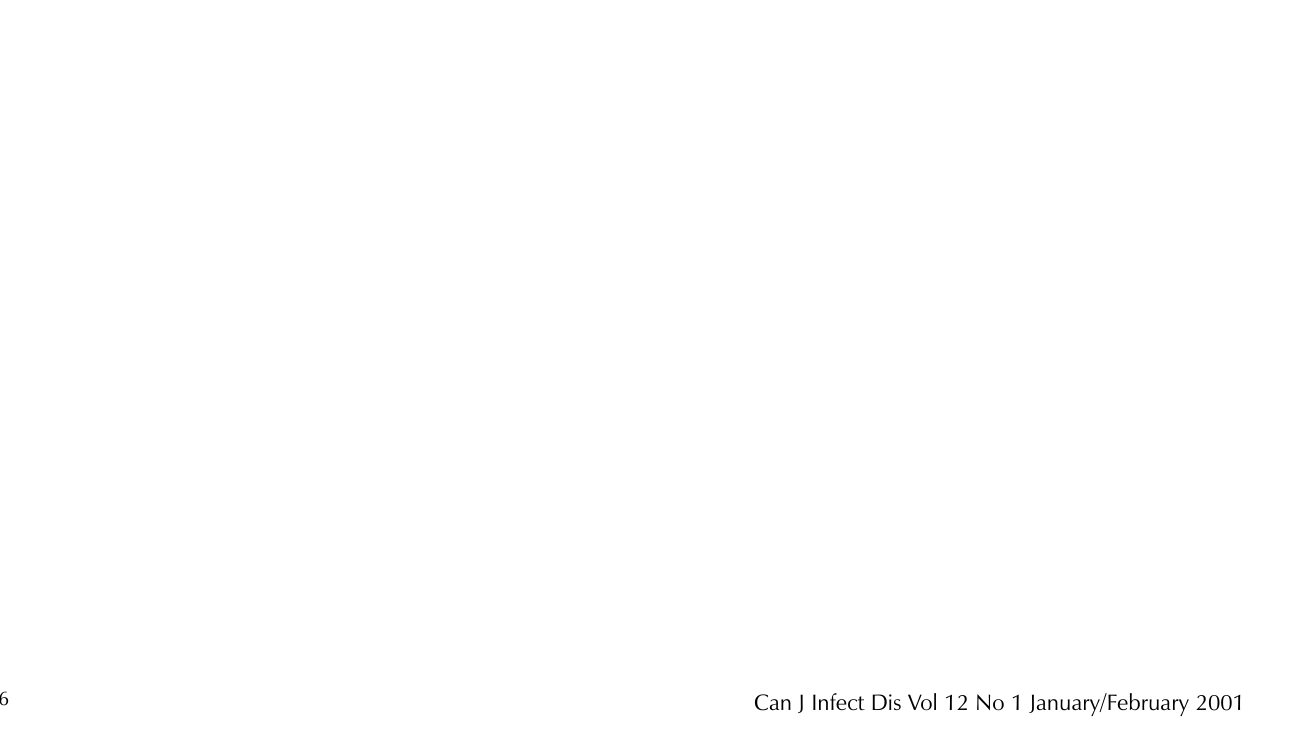
A chest x-ray (Figure 1) showed a large right pleural effu- sion with associated consolidation or subsegmental atelecta- sis in the rght middle and lower lung zones. An underlying parenchymal mass could not be excluded. Computed tom- ography of the thorax with contrast enhancement (Figure 2) revealed no masses in the lung parenchyma or the medi- astinum. However, it demonstrated a 10 cm fluid collection occupying most of the right lobe of the liver, with peripheral